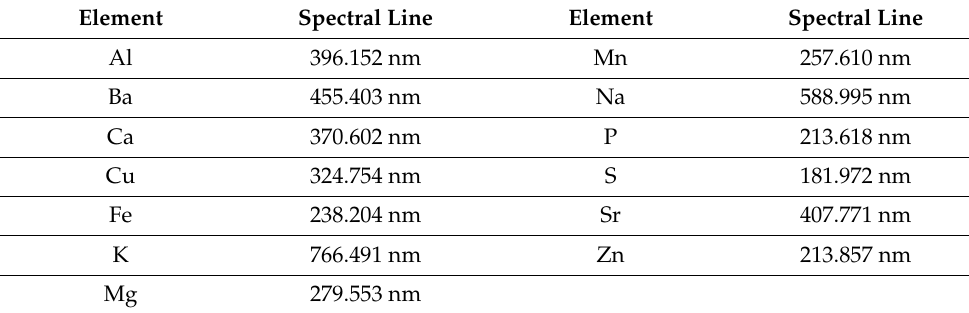
Table 2. Spectral lines for measuring elements by